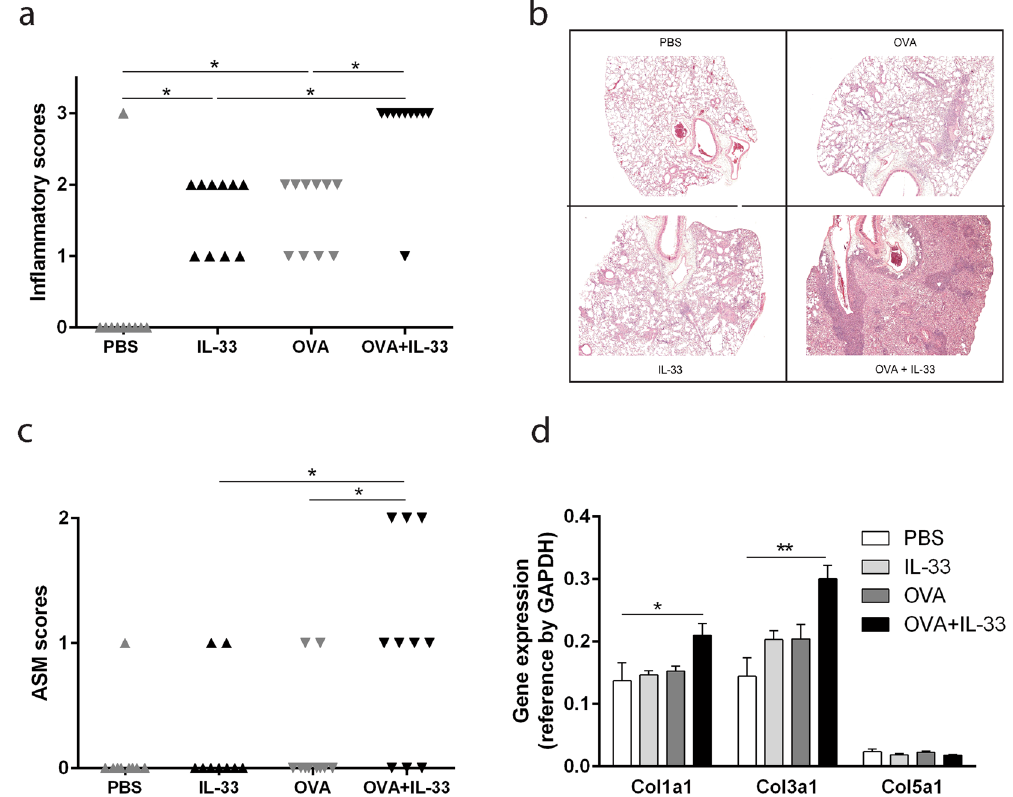
Figure 2. Lung tissue inflammation and structural airway remodeling is enhanced by IL-33 administration in OVA-sensitized mice. ( a ) Scoring of inflammation in lung tissue. 0 = no inflammatory cell infiltration, 1 = inflammatory cells present in central airways, 2 = inflammatory cells present in central airways and parenchyma, 3 = massive infiltration of inflammatory cell in the central airways as well as in the parenchyma. ( b ) Representative images of haematoxylin and eosin staining of lung tissue graded in panel 2a. ( c ) Scoring of the ASM cell layer around the central airways. The thickness of the ASM cell layer was assessed and a relative score was assigned to each sample, where 0 = normal, 1 = thickened and 2 = substantially thickened ASM cell layer. ASM = airway smooth muscle. ( a , c ) * p < 0.05 (Chi-square test for trend). Results are pooled data from four independent experiments (mean ± SEM of n = 9–10 mice for each group). ( d ) Relative quantitation (RQ) of mRNA levels of Col1a1 , Col3a1 and Col5a1 were assessed in lung specimens. * p < 0.05, ** p < 0.01 (ANOVA, Bonferroni). Results are pooled data from four independent experiments (mean ± SEM of n = 3–4 mice in each